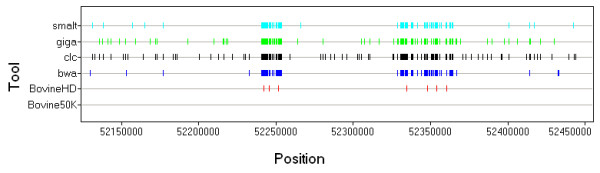
False heterozygous SNPs called within identical by descent (IBD) regions. Some false heterozygous SNPs called inside the IBD region on chromosome 9 by both the BovineHD BeadChip and resequencing pipelines were clustered close to each other, suggesting that they were caused by some systematic errors instead of random errors.